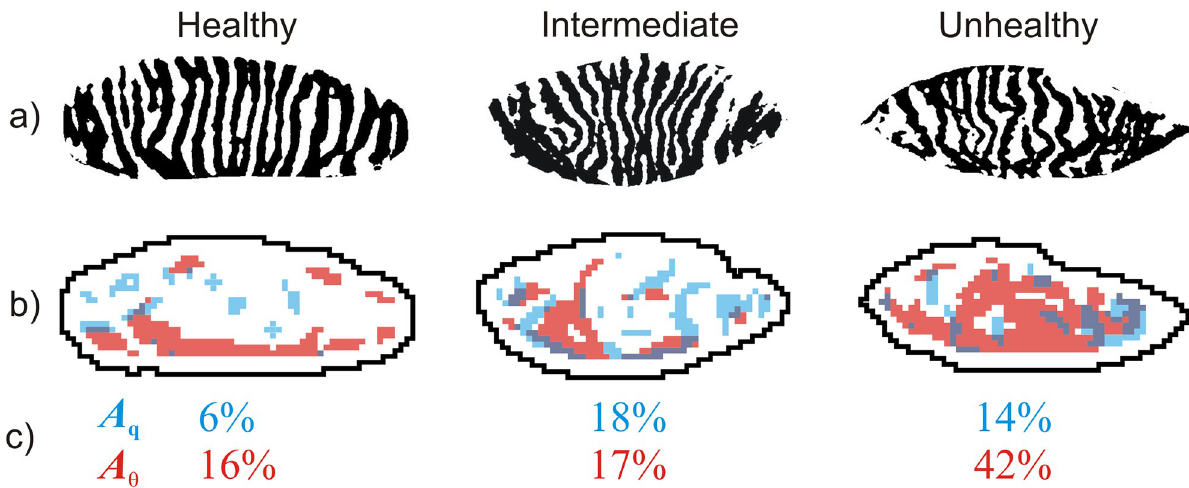
Fig 8. Definition of exemplary new morphometric parameters using the maps presented in Fig 5. Row a) original Meibomian images; Row b) locations where frequency gradient (blue regions) or angular incoherence (red regions) exceed an arbitrary threshold values of 0.007 and 0.1, respectively; Row c) percentages of the areas covered by glands with significant changes in the glands width ( A q , are of blue region) and with noticeable change in glands orientation ( A θ , area of red